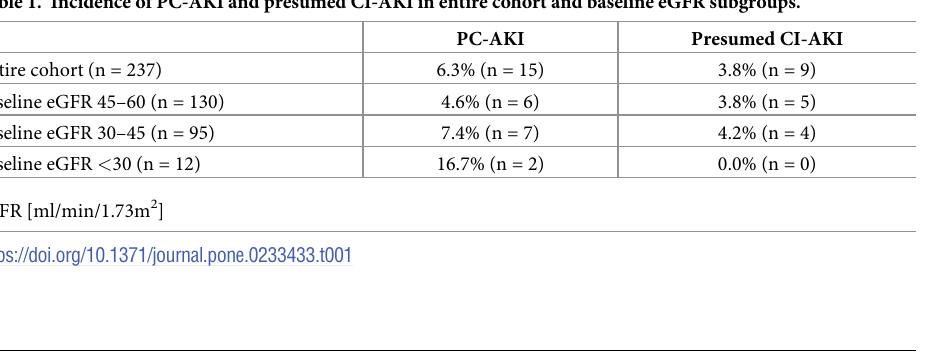
Table 1. Incidence of PC-AKI and presumed CI-AKI in entire cohort and baseline eGFR subgroups. Entire cohort (n =